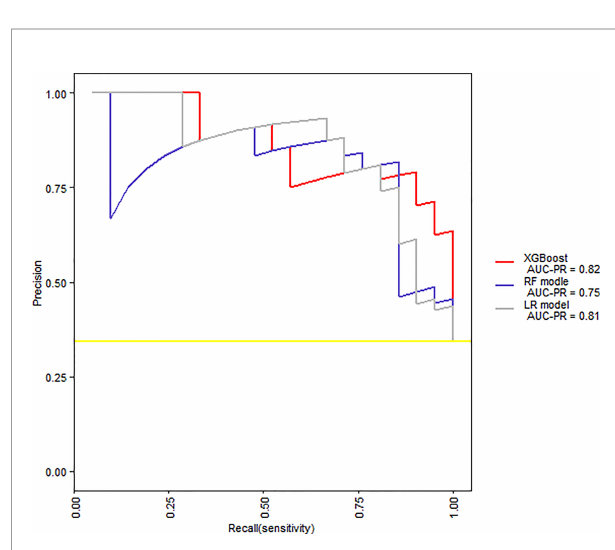
FIGURE 7 | Precision recall curves for the XGBoost, RF model, and LR